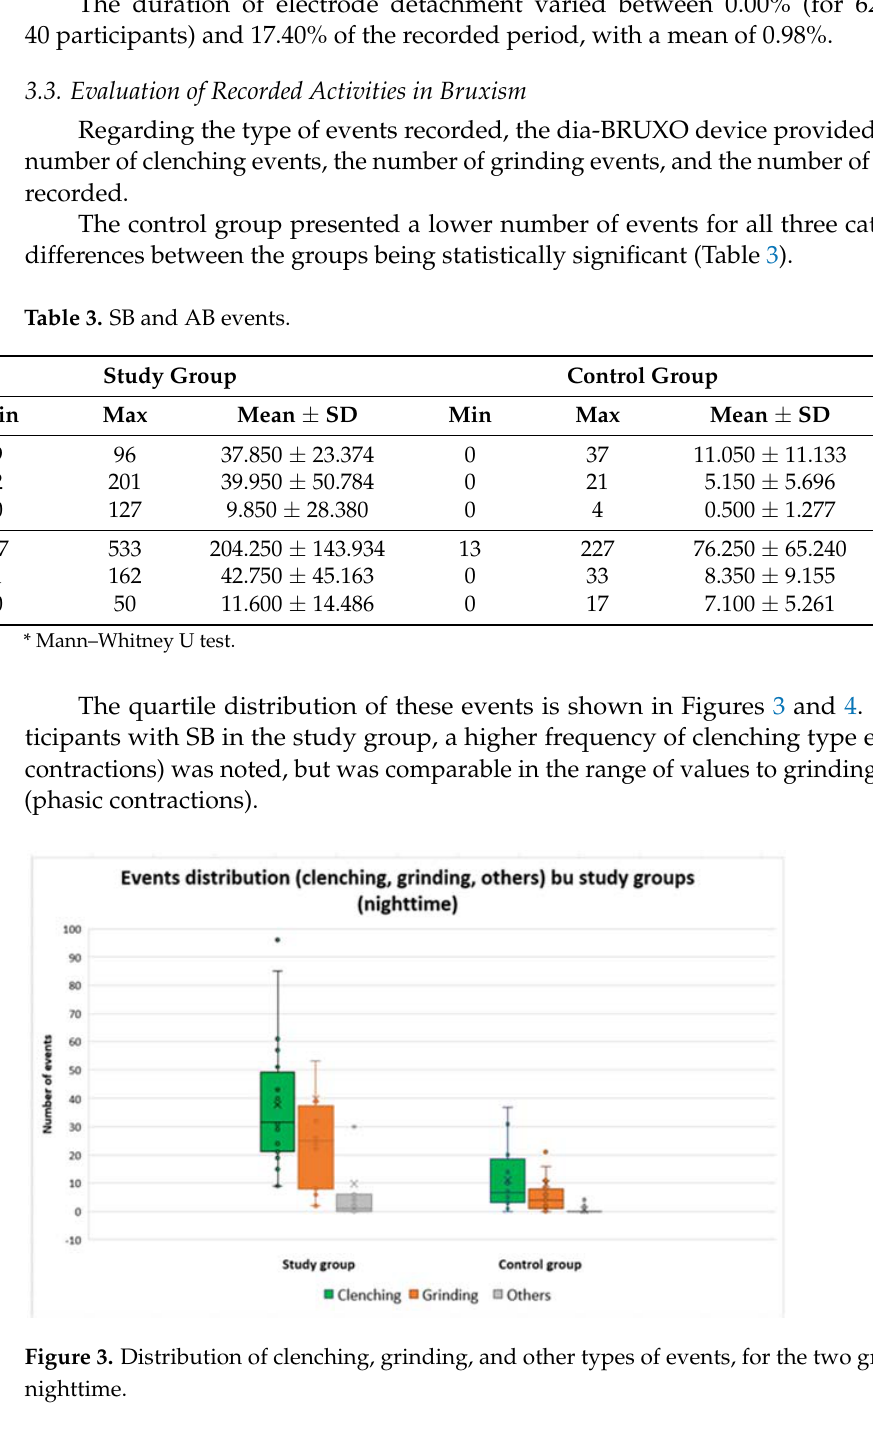
Table 2. Asleep and awake state duration and device detachment time.